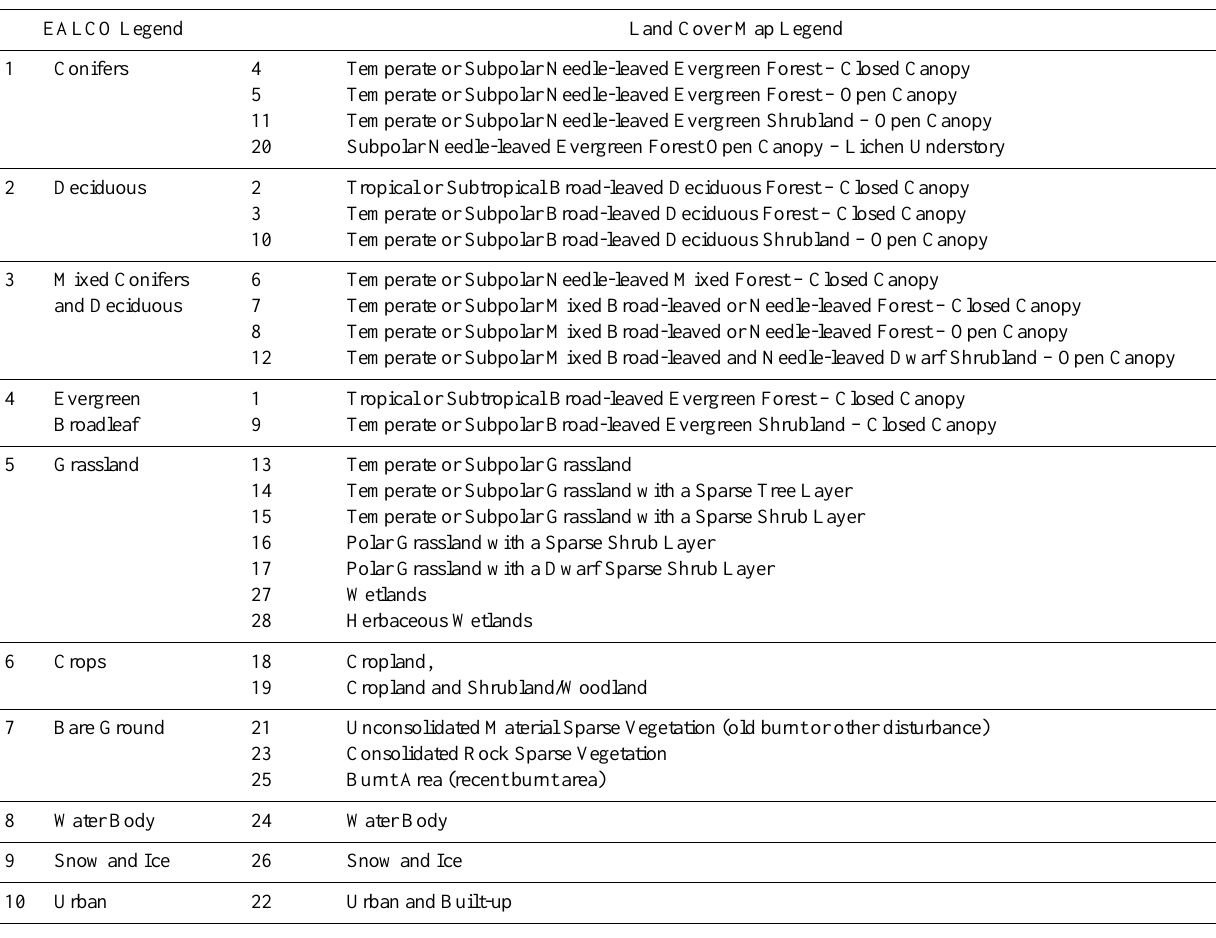
Table 1. Legends for the land cover classes in Fig. 1 and broad vegetation types in the EALCO model. EALCO Legend